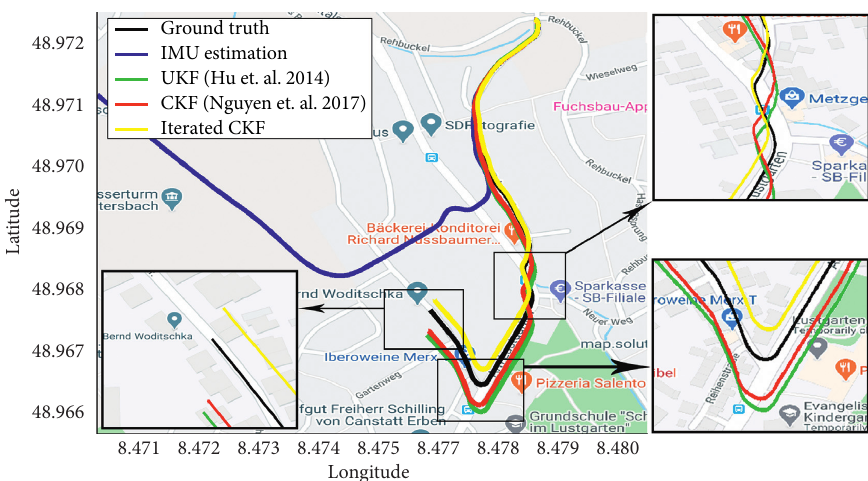
Figure 8: Experimental results presented in Google Maps for 2011_09_30_0034.